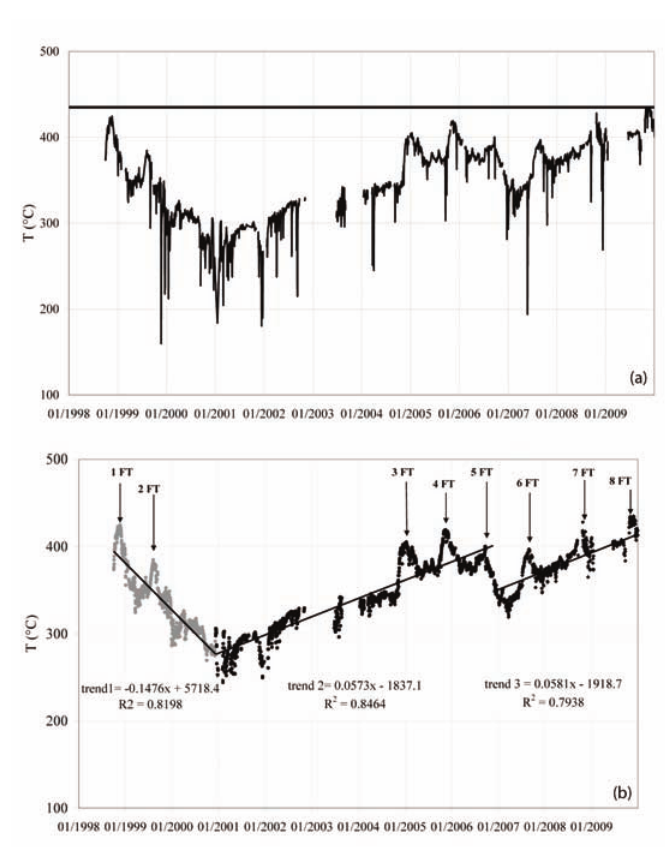
Figure 7. (a) Time-series from continuous monitoring of the fumarole temperatures, as the rough data from the F5AT station (January 1998 to December 2009). The horizonal line indicates the maximum temperature recorded over this period. (b) As for (a), after removing short-term rain effects. The equations under the linear plots correspond to the trends for the best-fits of the time variations. The peaks due to the fumarole temperature variations are labeled from 1 FT to 8